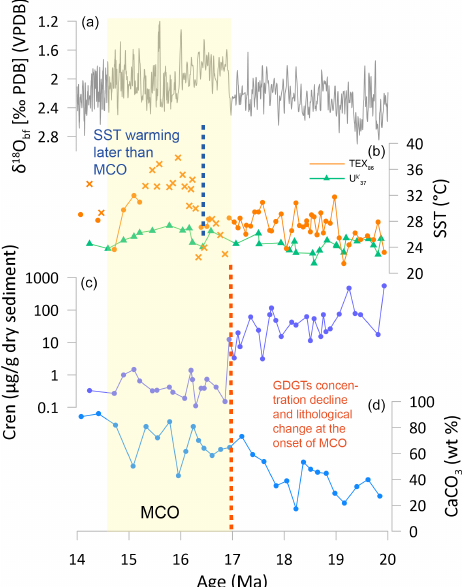
Figure 5. Lithology, GDGT concentrations and relative dis- tributions and SST changes in the mid-Miocene. (a) Benthic foraminiferal δ 18 O compilation (Westerhold et al., 2020). (b) SST (cid:48) changes based on TEX 86 and U k (this study; Guitián and Stoll, 37 2021). Orange dots indicate data points that are considered to be re- liable, and crosses indicate data points of TEX 86 that are considered to be unreliable. (c) The absolute abundance of cren as an indica- tor of GDGT preservation. (d) Weight% calcium carbonate indi- cating lithology change, inversely related to clay content (Robert, 2004). The dashed orange line indicates the change of lithology while isoGDGT preservation changes occur at the onset of MCO. The dashed blue line indicates the SST warming, postdating the MCO. The yellow bar indicates the interval of